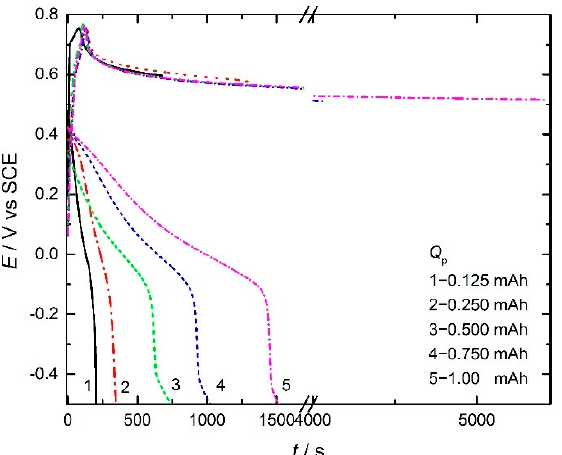
Figure 1. Galvanostatic curves of electrochemical polymerization of aniline in 1.0 mol dm − 3 H 2 SO 4 at the current density of 2.0 mA cm − 2 with different polymerization charges, as marked in the figure, together with discharge curves of PANI electrodes with 1.0 mA cm − 2 .